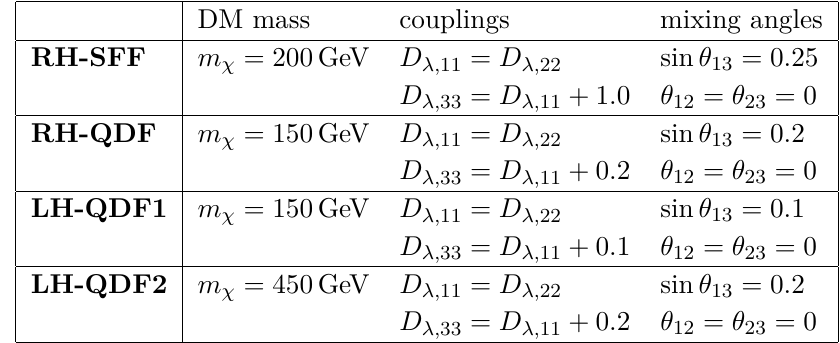
Table 1 . Definition of benchmark scenarios. In all cases the mediator mass m φ and the coupling D λ, 11 are free parameters, while the complex phases δ ij are set to zero.